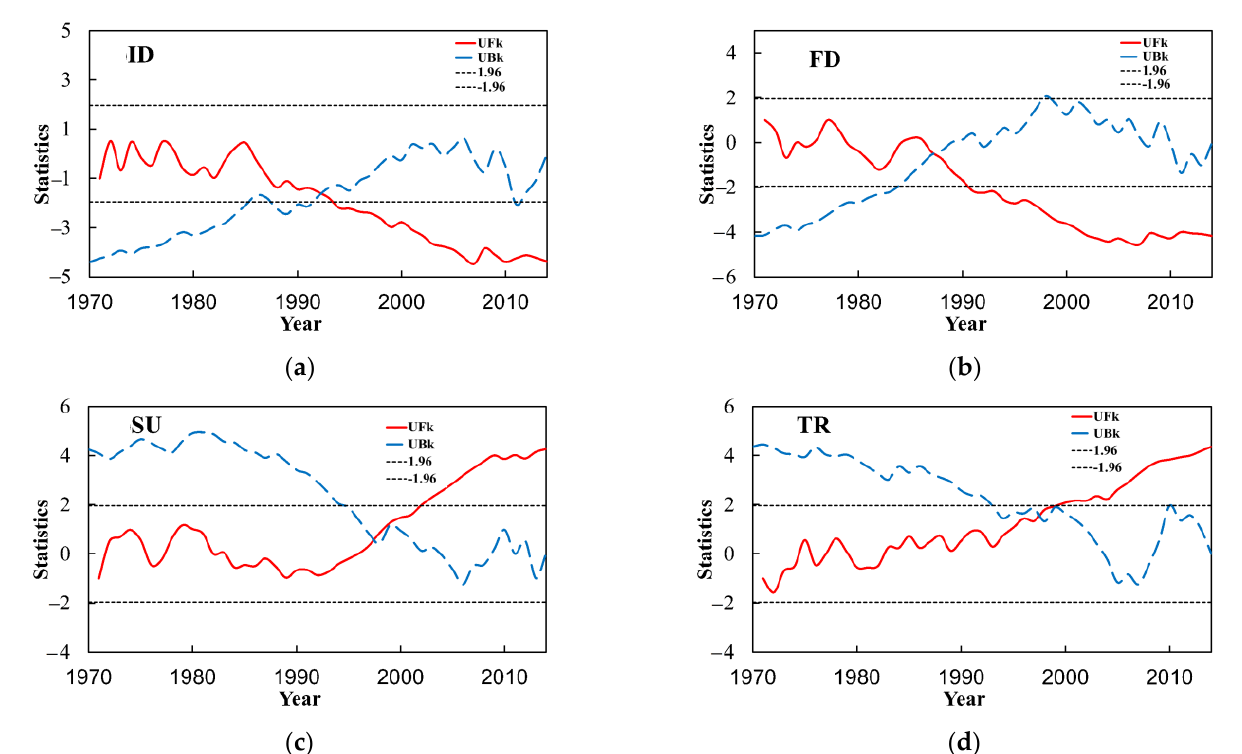
Figure 9. M – K abrupt change test of the absolute indices of extreme temperatures in the Yangtze River Basin from 1970 to 2014. (a) is ID, (b) is FD, (c) is SU and (d) is TR.